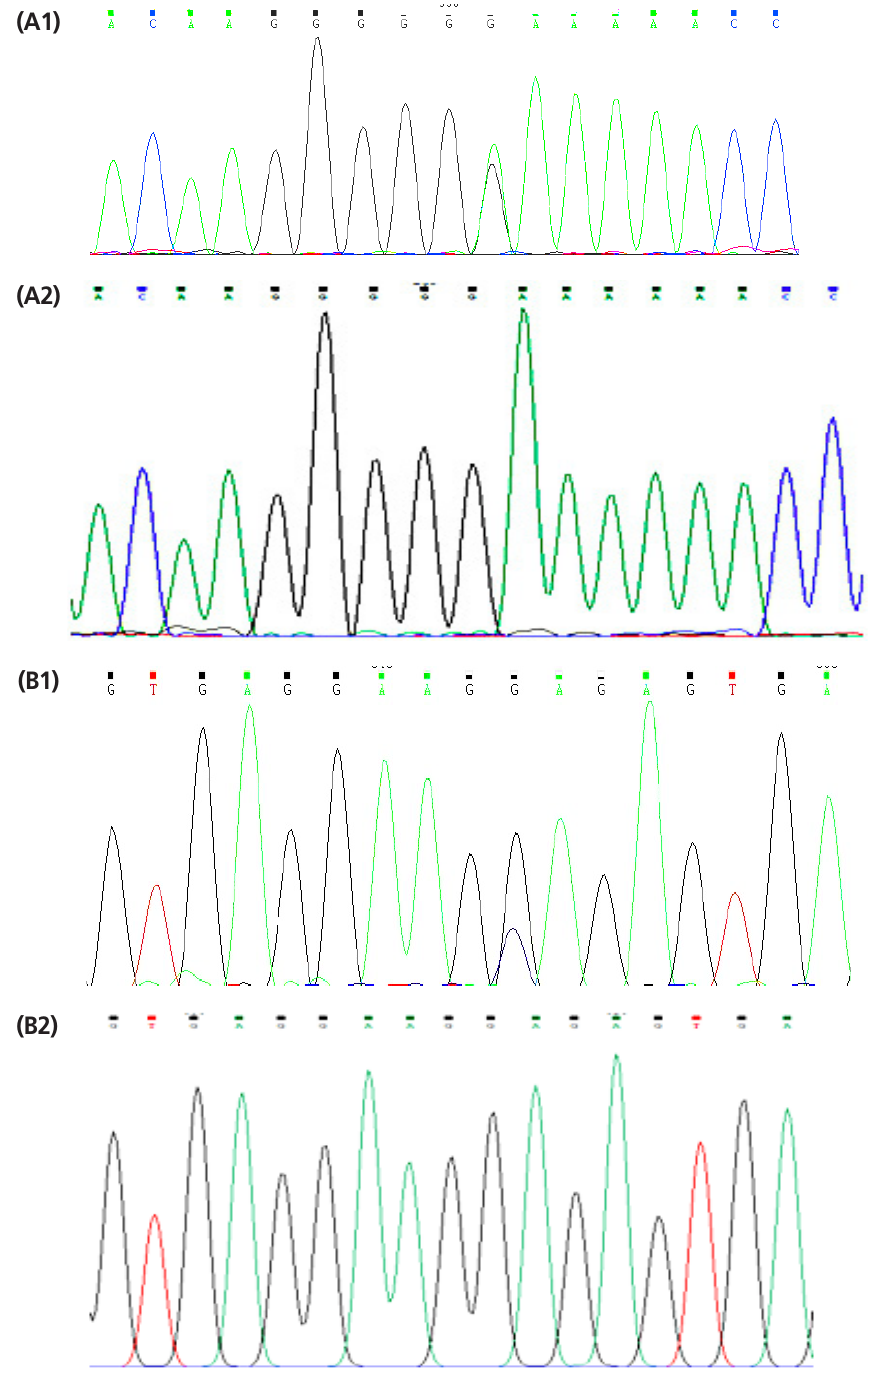
Figure 1. (A1) Sequencing maps at position of SNP rs2381 A → G in the yak MMP3 gene. (A2) Sequencing maps at position of SNP rs2381 A → G in the cattle MMP3 gene. (B1) Sequencing maps at position of SNP rs4331C → G in the yak MMP3 gene. (B2) Sequencing maps at position of SNP rs4331C → G in the cattle MMP3 gene. SNP, single-nucleotide polymorphisms; MMP3, matrix